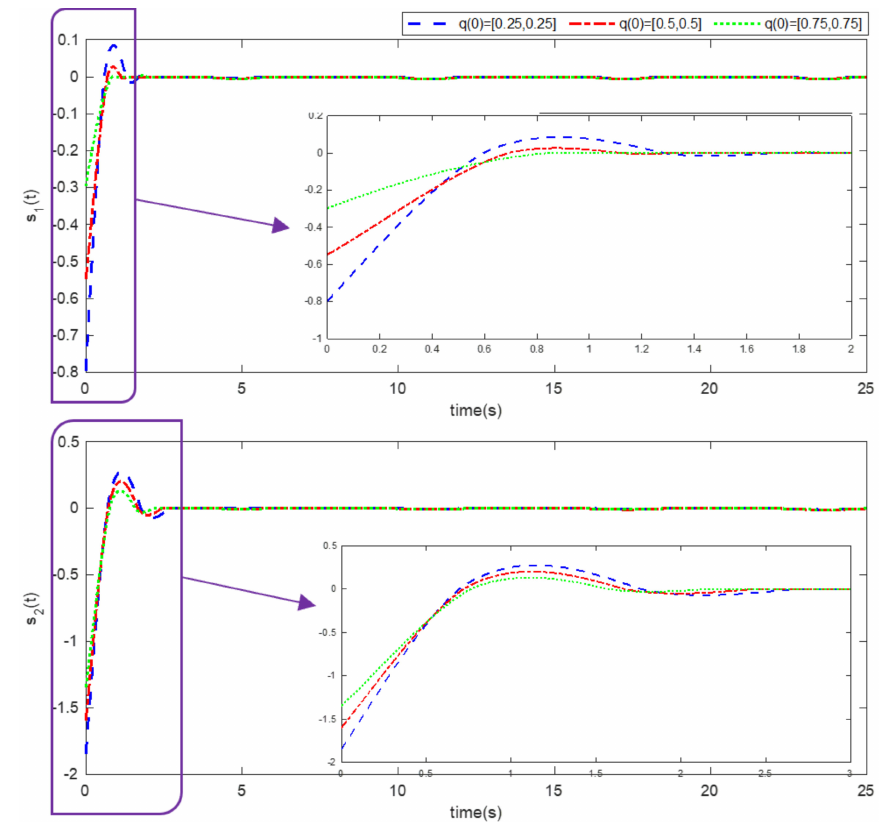
Figure 6. Time history of the sliding surface (Example